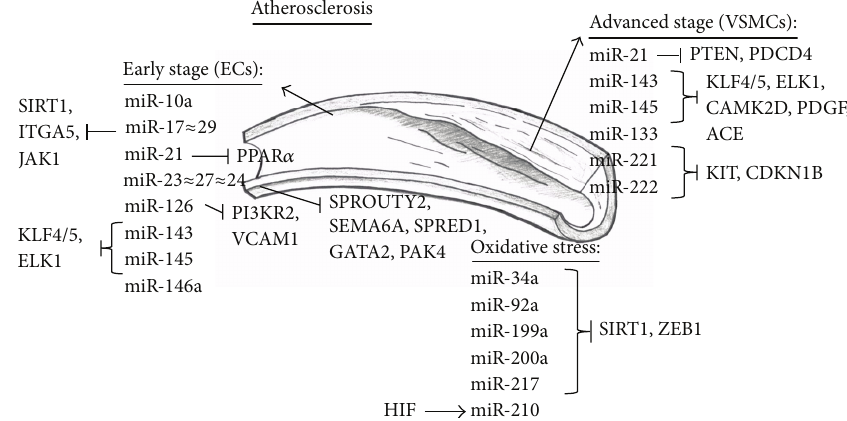
Figure 3: miRNAs involved in vascular pathophysiology. ECs: endothelial cells; VSMCs: vascular smooth muscle cells; SIRT1: silent mating type information regulation 2 homolog; ITGA5: integrin subunit 𝛼 5; JAK1: Janus kinase 1; KLF: Kr¨uppel-like factor; ELK1: ETS domain- containing protein Elk1; PPAR 𝛼 : peroxisome proliferator-activated receptor 𝛼 ; SPROUTY2: sprouty protein 2; SEMA6A: semaphorin-6A; SPRED1: sprouty-related, EVH1 domain-containing protein 1; GATA2: GATA-binding protein 2; PAK4: p21 protein-activated kinase